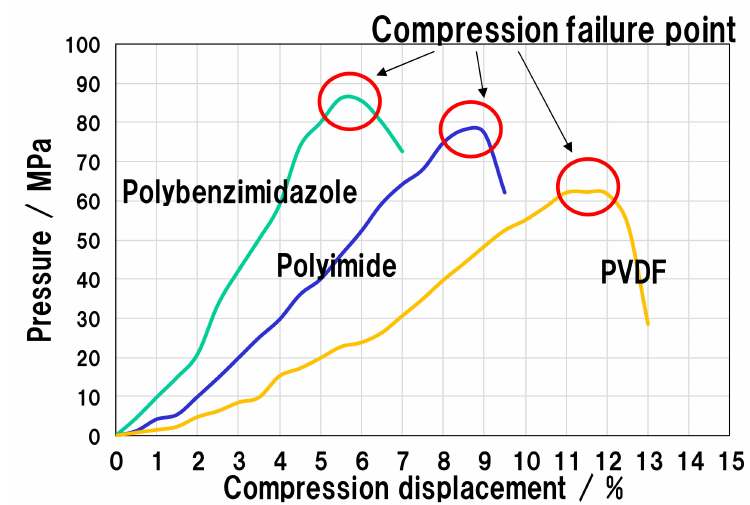
Figure 4. Comparison with compression displacement and deformation rate of a pellet.